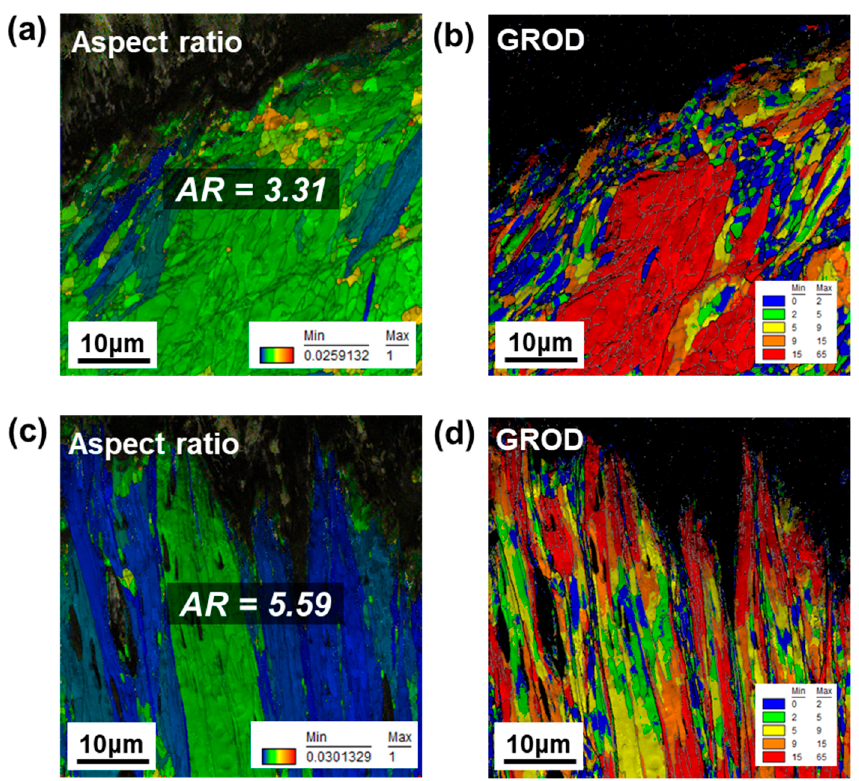
Figure 8. The grain aspect ratio and GROD maps of deformed RX-W sample: ( a , b ) static (1.3 × 10 − 4 s − 1 ); ( c , d ) high-strain-rate (5.3 × 10 − 1 s − 1 ) conditions.